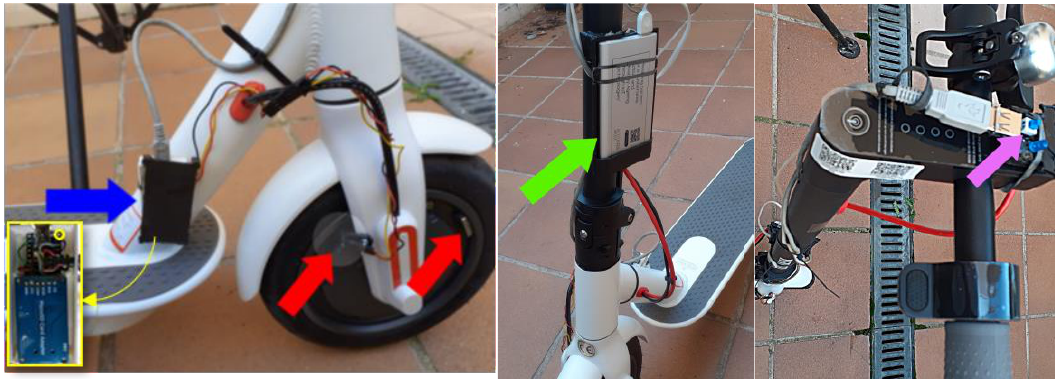
Figure 3. Sensors and data acquisition system installed in the e-scooter. The blue arrow indicates the box (4 cm × 7 cm) that contained the Arduino, SD reader, and accelerometer (ADXL335), which was fixed by screwing it directly to the chassis of the scooter with an M3 screw placed at the yellow ring location indicated in Figure 3. The red arrow on the left points to the 49E auto-switch, and the one on the right points to the magnet attached to the wheel. The green arrow indicates the position of the lithium battery that powered the system, and the purple arrow shows the switch and LEDs that indicated the data-recording process.